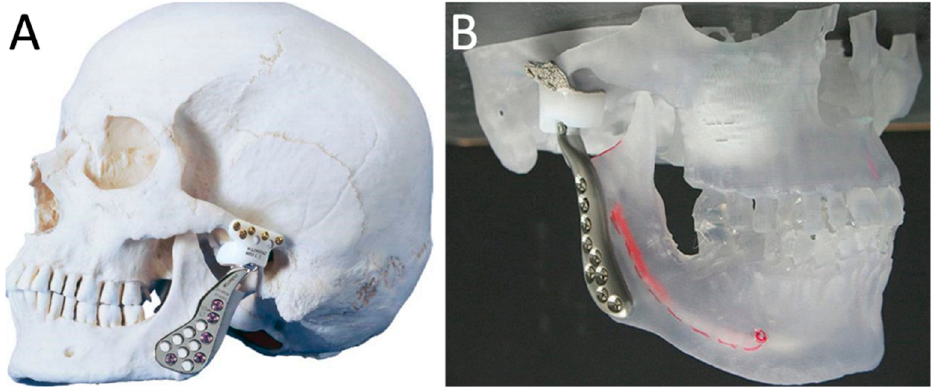
Figure 1. Images of ( A ) a standard and ( B ) a custom-made temporomandibular joint total joint replacement (TMJ TJR) prosthesis.